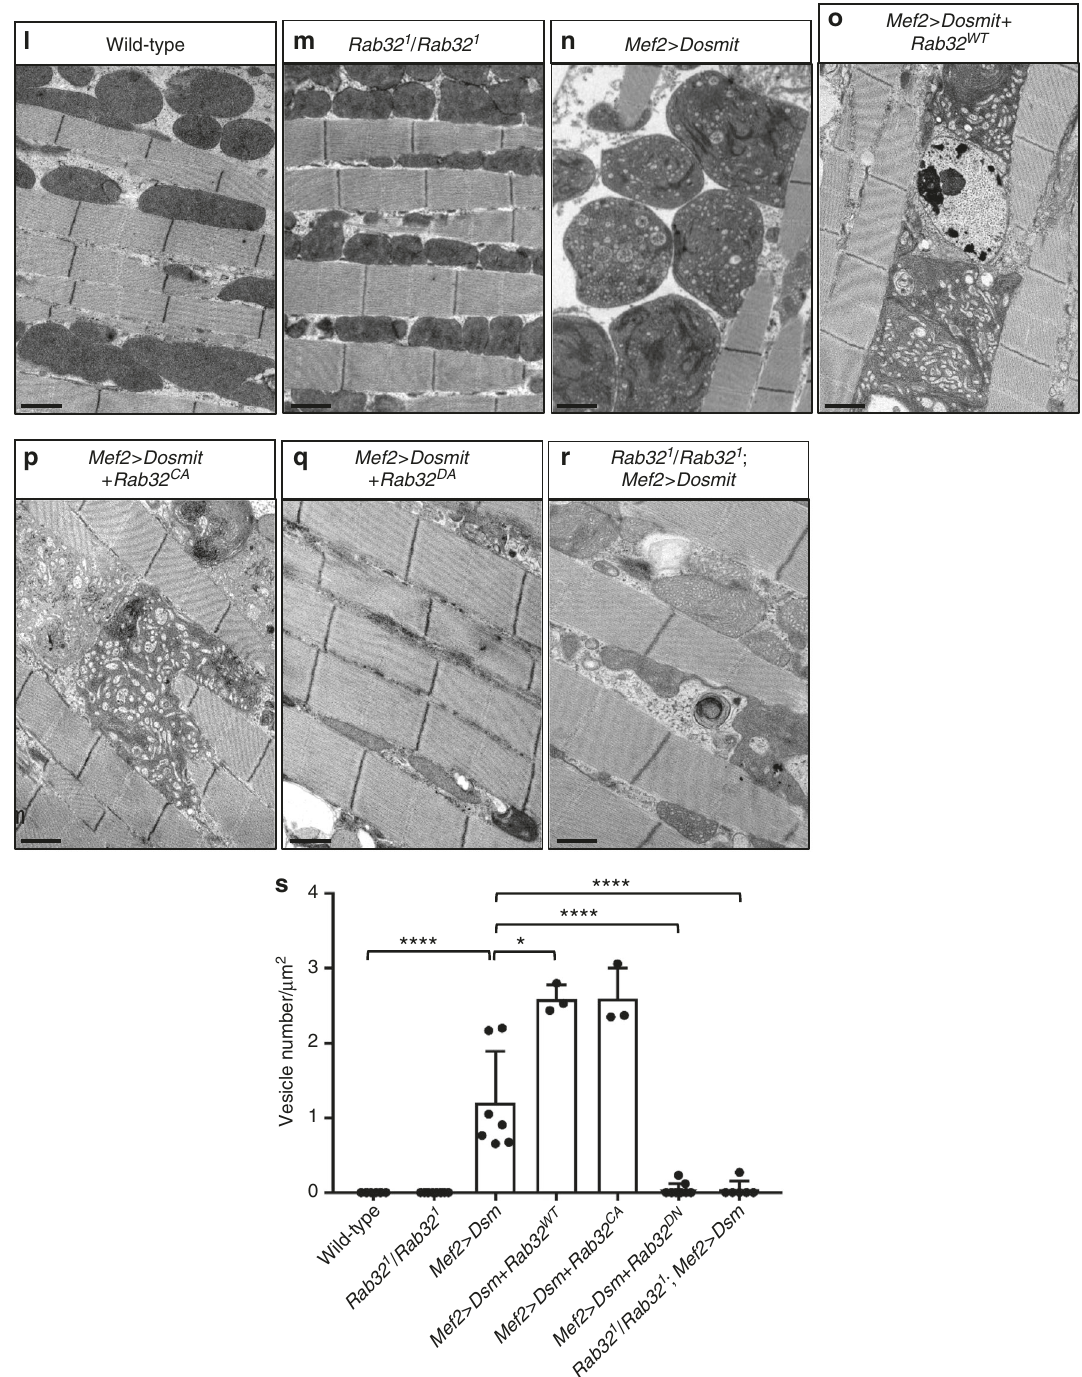
Fig. 10 The mitochondria-associated protein Rab32 mediates the Dosmit-induced enlargement of mitochondria. Mitochondria from: a , e Mef2/ + control fl ies, b fl ies with ectopic expression of wild-type Rab32, c Rab32 1 /Rab32 1 fl ies, f Mef2 > Dosmit fl ies (in which Dosmit was ectopically expressed), g Mef2 > Dosmit + YFP-Rab32 WT fl ies (in which both Dosmit and wild-type Rab32 were ectopically expressed), h Mef2 > Dosmit + YFP-Rab32 CA fl ies in which both Dosmit and the constitutively active GTP-binding Rab32 mutant (Rab32 CA ) were ectopically expressed, i Mef2 > Dosmit + YFP-Rab32 DN fl ies in which both Dosmit and the dominant-negative form of Rab32 (Rab32 DN ) were ectopically expressed, and j Rab32 1 /Rab32 1 ; Mef2 > Dosmit fl ies in which Dosmit was ectopically expressed in the Rab32-null mutant background. d Distribution of size classes of mitochondria in the various genetic backgrounds. N = 62, 124, and 115 from left to right bars. Statistical test: Chi-Square Test (* p < 0.05). Green channel shows ATP5A staining; red channel shows phalloidin staining of F-actin in muscle. Scale bars: 10 μ m. k Distribution of size classes of mitochondria in the various genetic backgrounds. N = 146, 43, 34, 26, 126, and 131 from left to right bars. Statistical test: Chi-Square Test (**** p < 0.0001; ns: p = 0.0673). l – r TEM images of mitochondria from wild-type, Rab32 1 / Rab32 1 , Mef2 > Dosmit (Dsm) , Mef2 > Dosmit + Rab32 WT , Mef2 > Dosmit + Rab32 CA , Mef2 > Dosmit + Rab32 DN , and Rab32 1 /Rab32 1 ; Mef2>Dosmit muscle tissue. Scale bars: 2 μ m. s Number of vesicles per unit area for 1-week-old fl ies from panels l – r (mean ± SD). N = 8, 10, 7, 3, 3, 9, and 6 from left to right bars. Statistical test: Two-tailed Mann – Whitney U -test (**** p < 0.0001; * p < 0.05). Source data are provided as a Source data fi